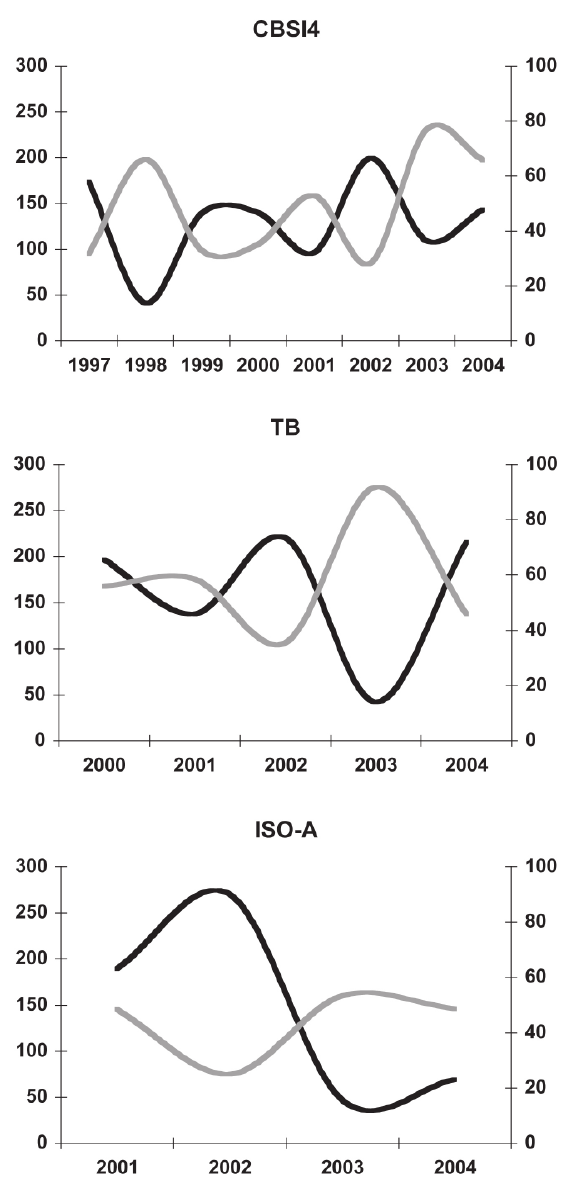
Fig. 4. Relation between rainfall in May, June and July and the percentage of standing vines with hidden (i.e. asymptomatic) esca in three vineyards at Siena (CBSI4), Ravenna (TB) and Florence